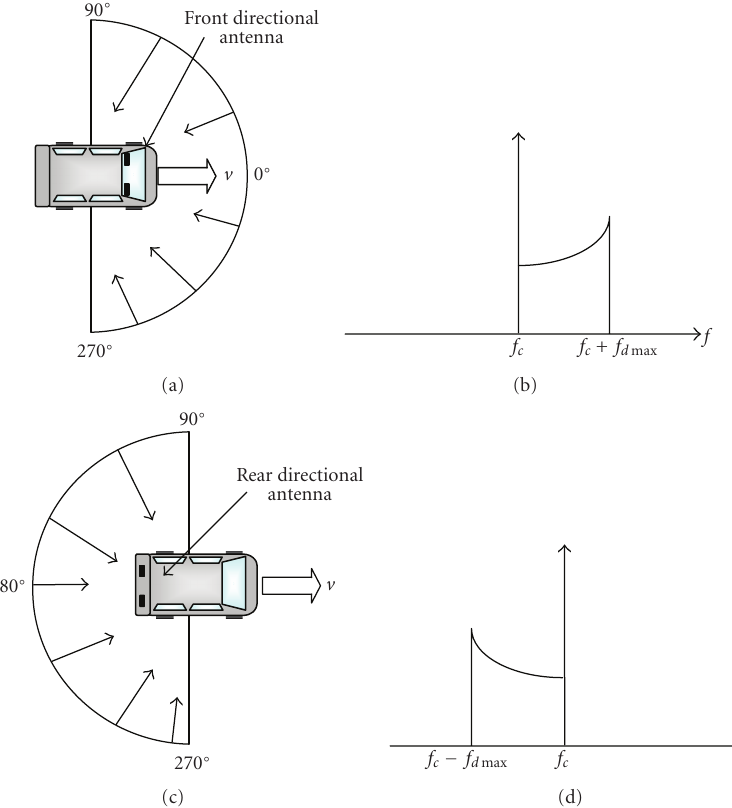
Figure 4: Doppler frequency shift for front and rear directional antenna: (a) and (b) front directional antenna; (c) and (d) rear directional antenna.